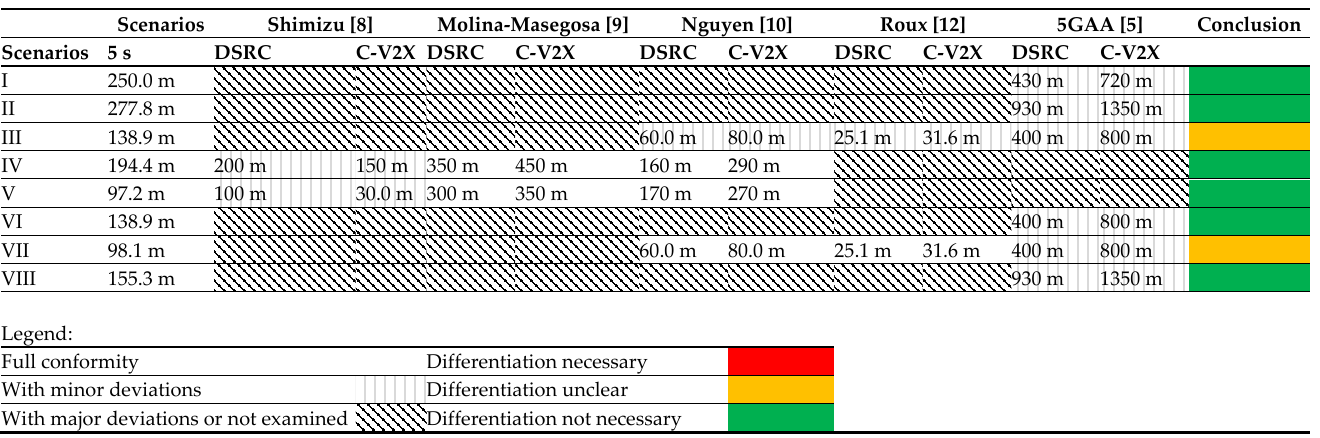
Table 2. Summary of the calculated ranges of the scenarios and the corresponding studies from the literature.